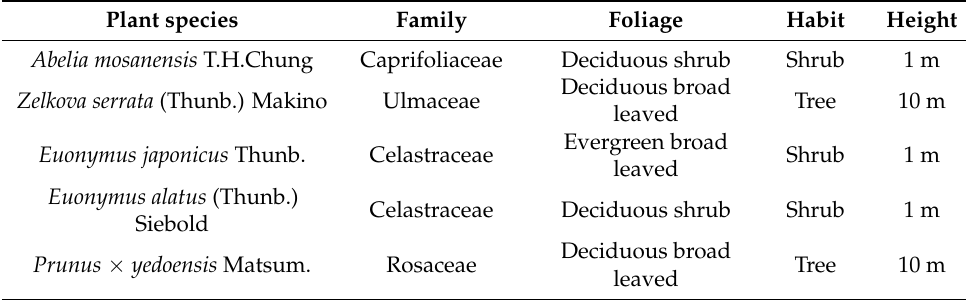
Figure 1. Sampling site. Cheongju city, South Korea (36 ◦ 38 (cid:48) 0” N, 127 ◦ 29 (cid:48) 0” E). Table 1. List of five plants analyzed in this study. Table 1. List of five plants analyzed in this